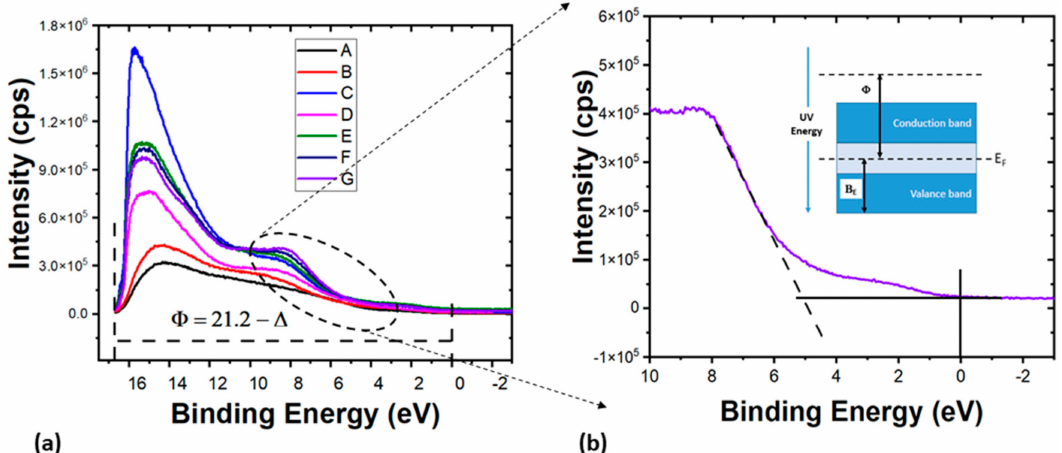
Figure 9. UPS survey spectra using ( a ) a He(I) source for all samples A–G; and ( b ) high-resolution spectra around the Fermi level for sample G. The insert is a representation of the conduction and valance band relative to the Fermi level for a metal. B E is the binding